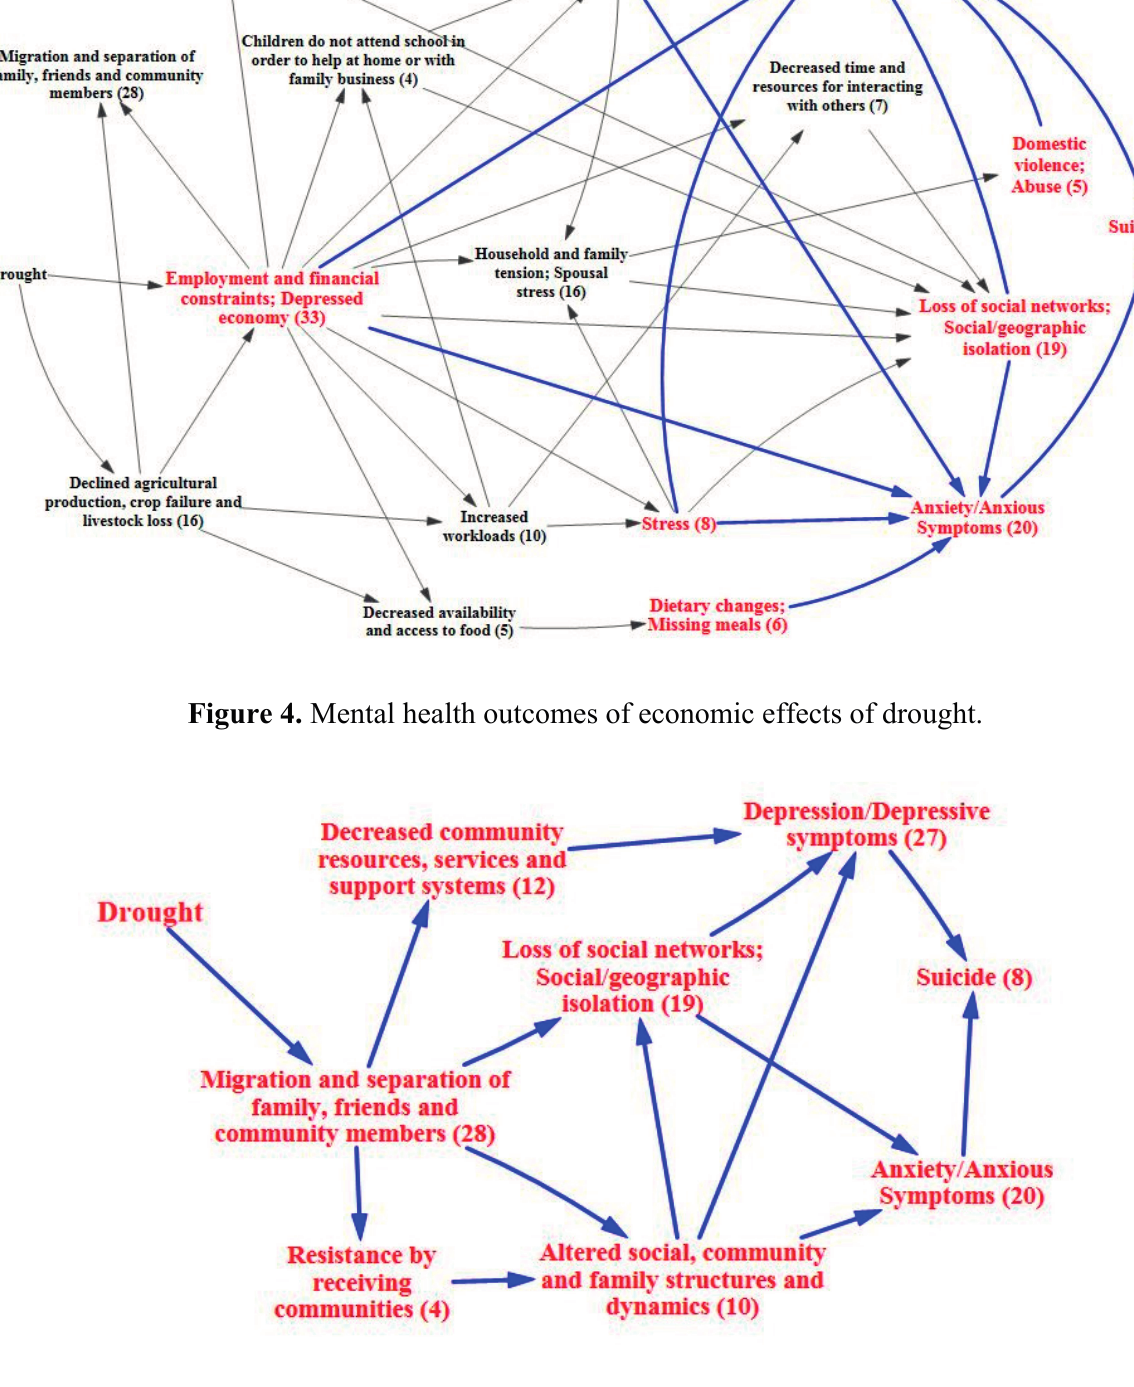
Figure 5. Migratory effects of drought upon mental